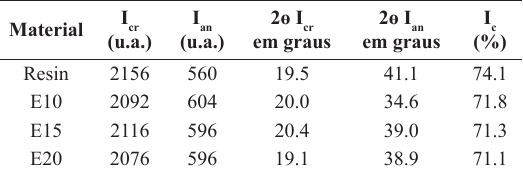
Table 5. Composite and resin degree of